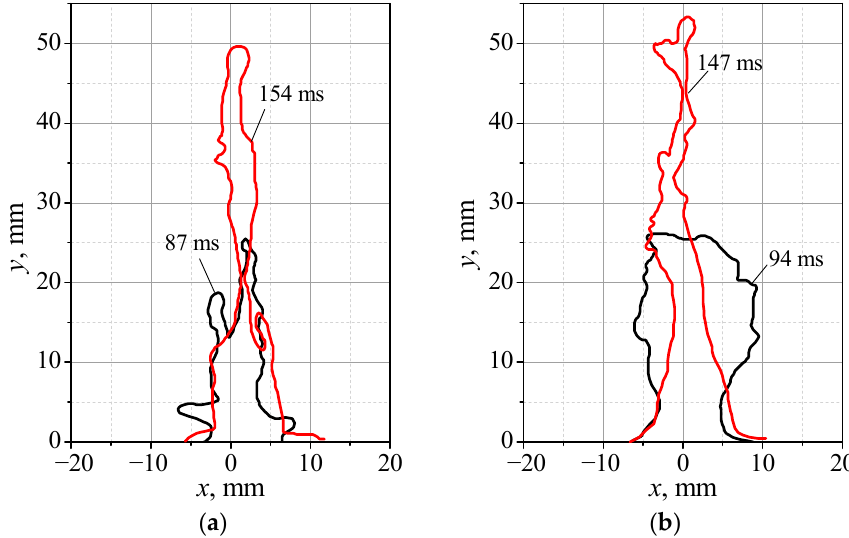
Figure 8. Melt–water jet interaction, Cases J4 ( a ) and J5 ( b ): shape of the cumulative jet at different times.